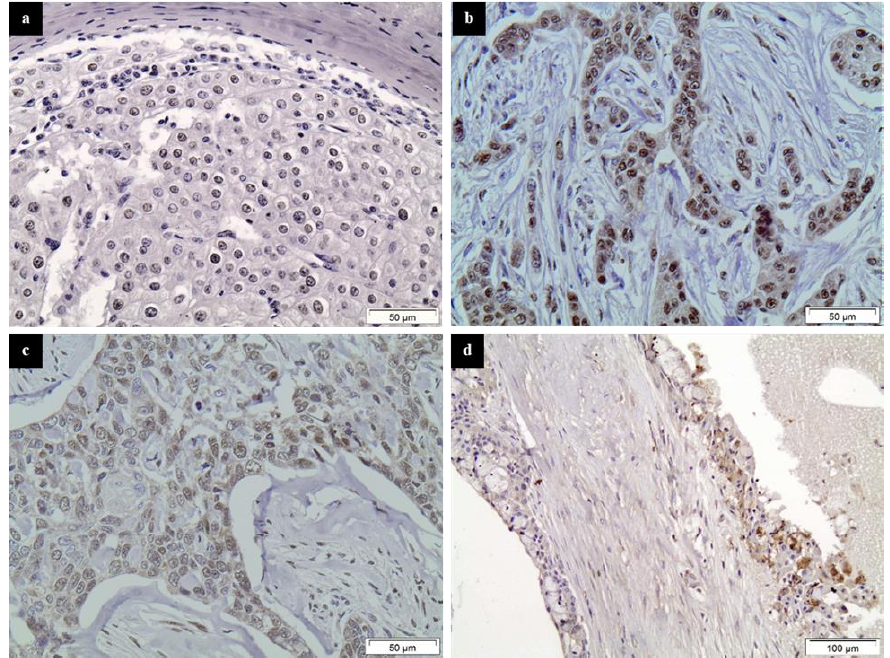
Figure 2. Representative immunostainings of HDAC-1, -2, -4 and -6 in malignant SGTs. ( a ) HDAC-1 in a HG ACC, ( b ) HDAC-2 in a HG SDC, ( c ) HDAC-4 in a HG SCC and ( d ) HDAC-6 in a HG MEC. Streptavidin-biotin-peroxidase, DAB chromogen, Harris hematoxylin counterstain. Class I HDAC-1 was expressed in about 31% of benign and 14% of malignant SGT